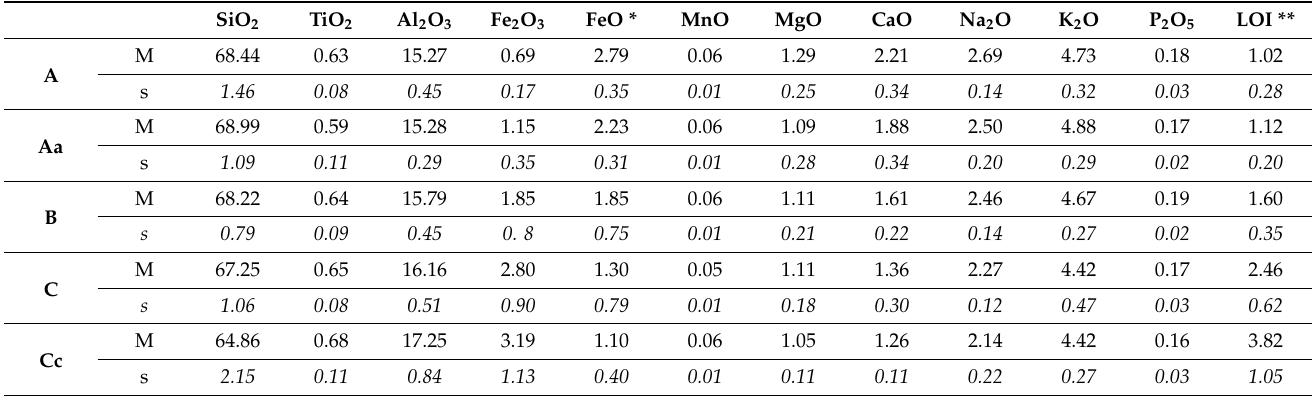
Table 2. Chemical composition of major and minor elements from unweathered (A) to weathered samples (Aa, B, C, Cc) expressed as oxide weight